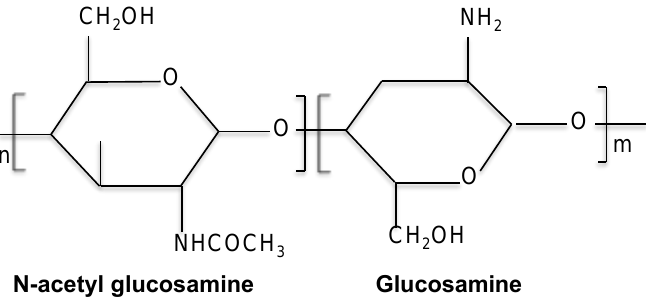
Figure 3. Schematic representation of chitosan chemical structure.